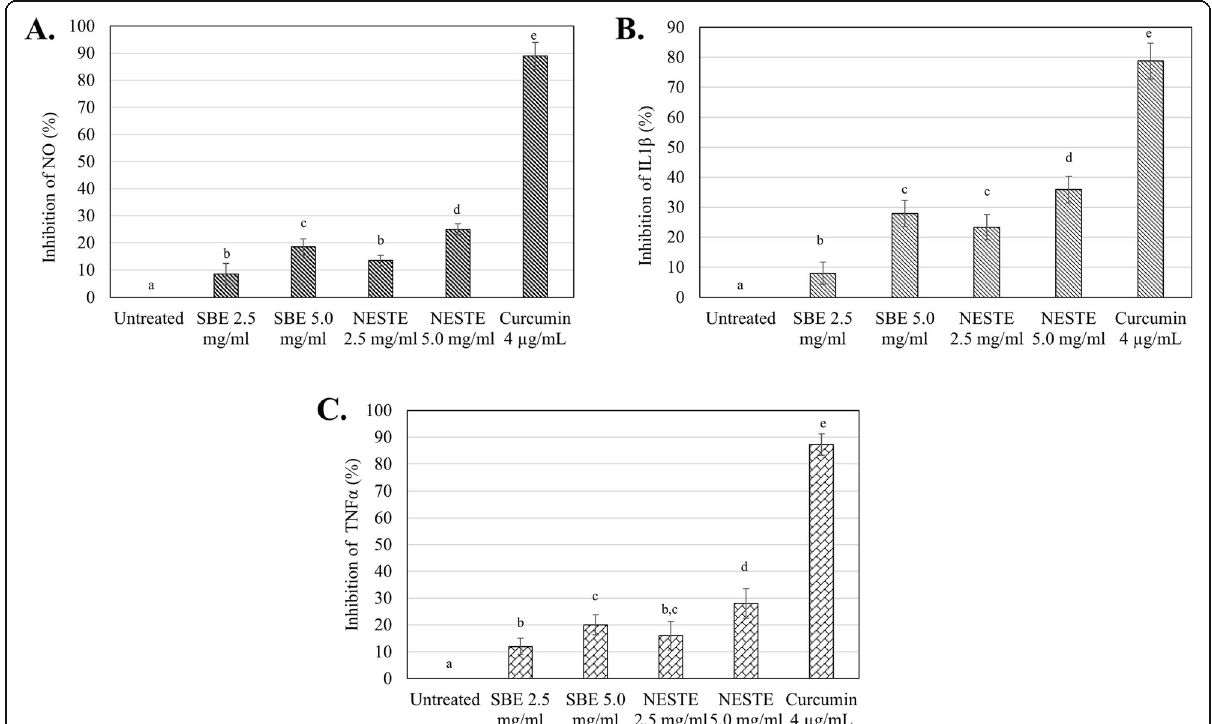
Fig. 2 The effect of SBE and NESTE treatments towards the percentage of a nitric oxide; b IL1 β ; c TNF α inhibition on LPS-induced RAW264.7 cells. Note: All of the values are expressed as means ± S.E.M. from three separate experiments, ‘ a ’ value has a significance differences ( p < 0.05) with ‘ b ’ value